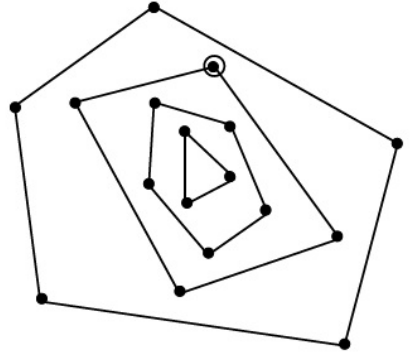
Figure 20: Deletion of a point.